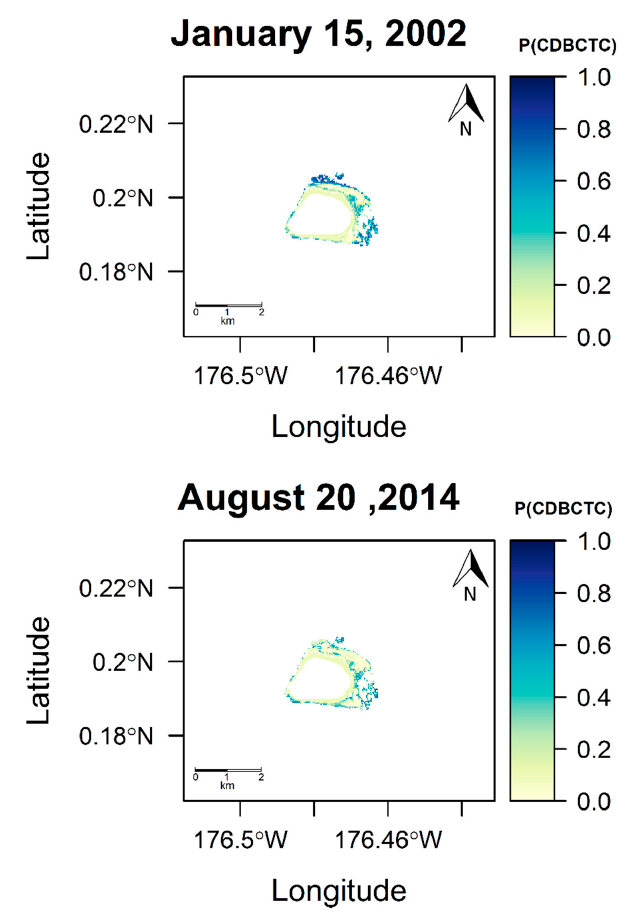
Figure9. PosteriorprobabilitymapfortheBakerIslandAtollareaofinterest(top, Figure 9. Posterior probability map for the Baker Island Atoll area of interest (top, 2002 and bottom, 2014).